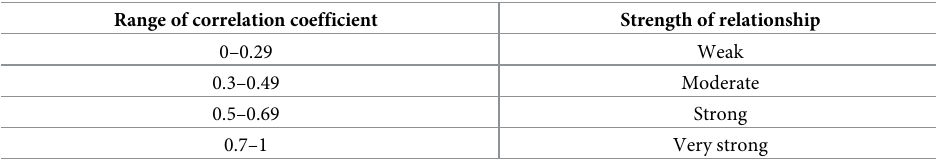
Table 3. Interpretation of the correlation